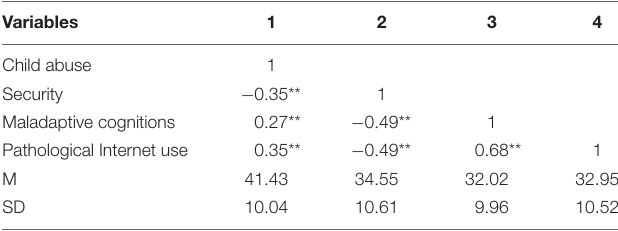
TABLE 1 | Descriptive statistics and correlation analysis of